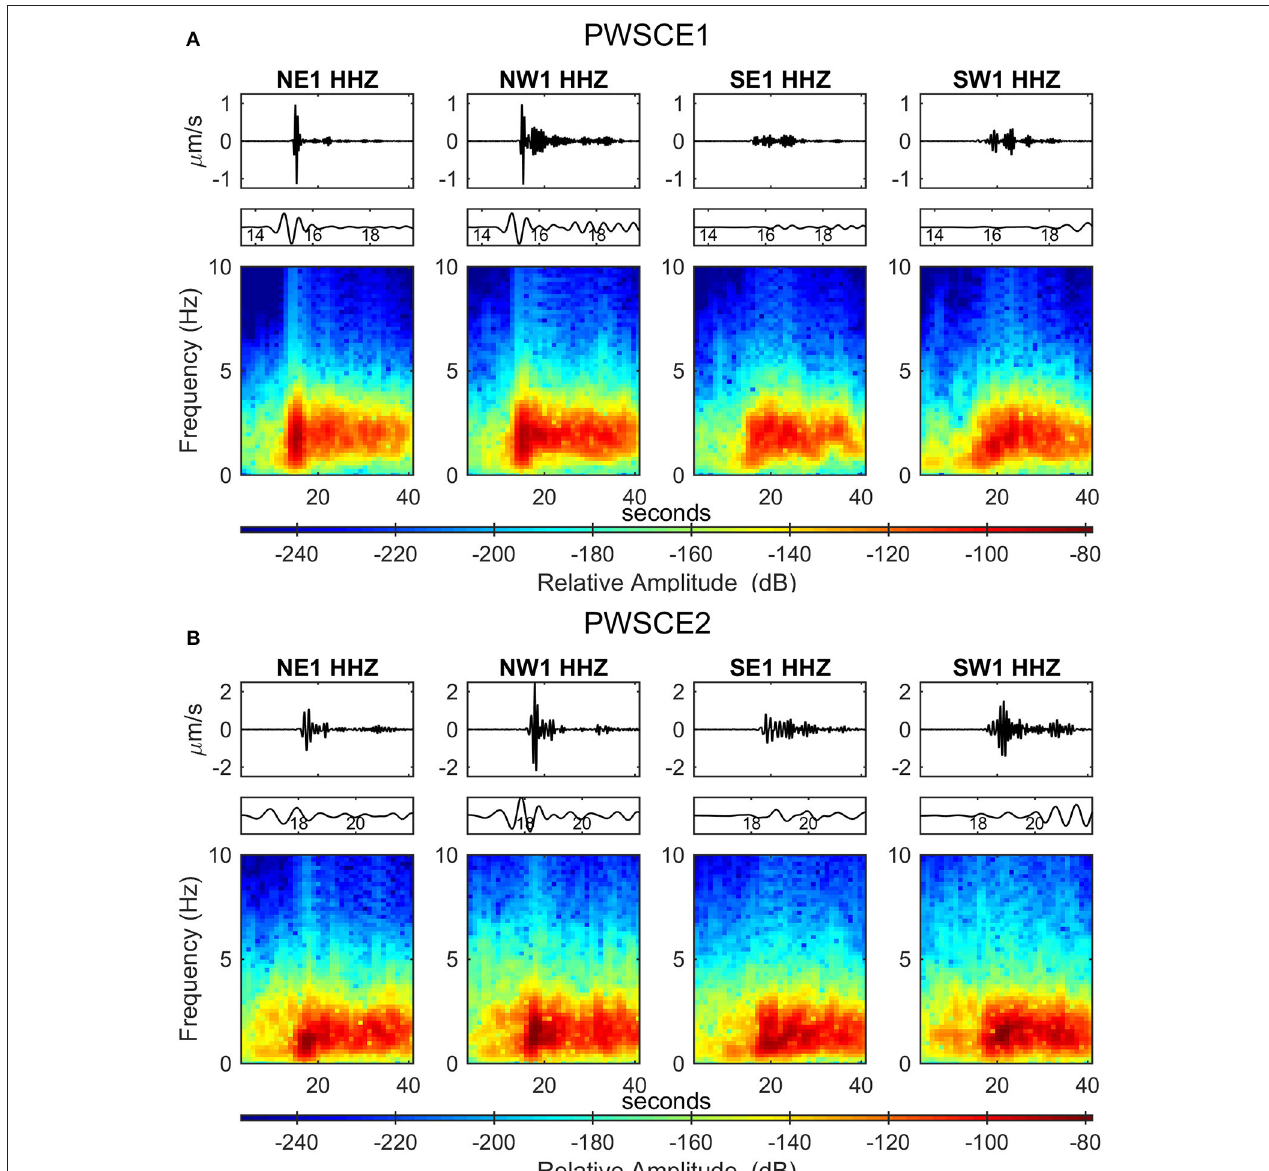
FIGURE 9 | (A) Top Row—PWSCE1 traces. Middle Row-Zoom-in of stacked signal onset. Bottom row-Spectrogram (5.12s sample Parzen window with 80% overlap and 512 point nfft) of PWSCE1. (B) Top Row—PWSCE2 traces. Middle Row—Zoom-in of stacked signal onset. Bottom row—Spectrogram (5.12s sample Parzen window with 80% overlap and 512 point nfft) of